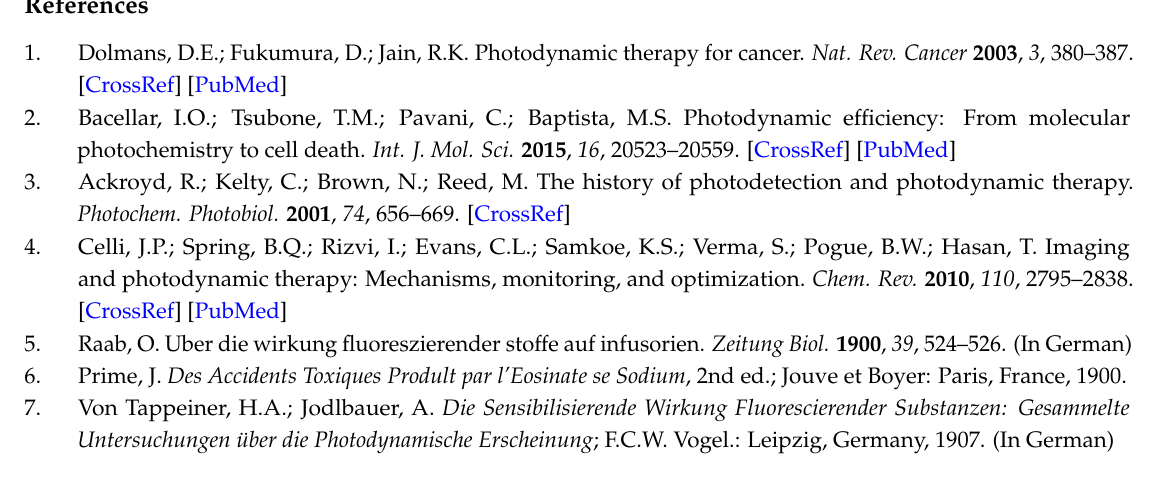
Table S1: Summary of clinical studies